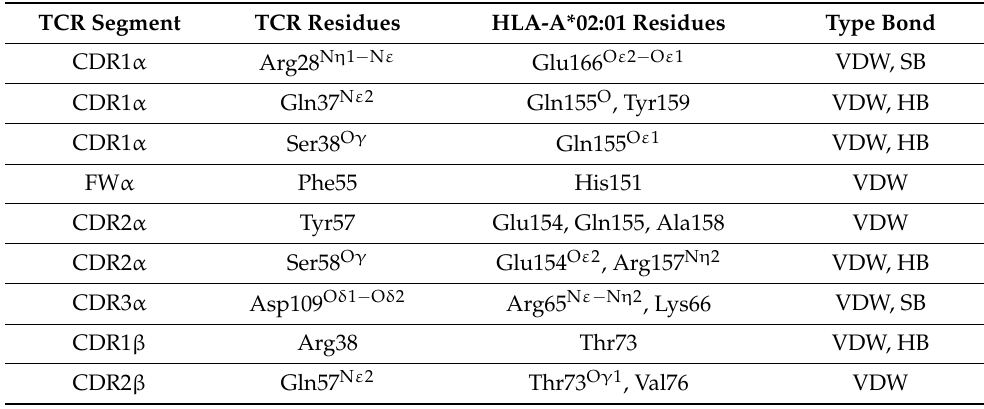
Figure 3. YLQ-SG3 TCR affinity and structure with HLA-A*02:01-YLQ. ( A ) SPR sensorgram and ( B ) steady-state binding curve for YLQ-SG3 TCR towards HLA-A*02:01-YLQ. Analyte HLA-A*02:01- YLQ flowed over immobilised YLQ-SG3 TCR with a concentration range of 0.19 to 50 µ M. ( C ) The footprint of the YLQ-SG3 TCR shows atomic contact with the HLA-A*02:01-YLQ complex. The surface of HLA-A*02:01 is white, the surface of the YLQ peptide is grey. Each atom is coloured by the TCR segment they are contacted by, which for the CDR1/2/3 α is deep teal, chartreuse and purple, for the CDR1/2/3 β is red, orange and yellow and the β -chain framework is light blue. The pink and blue spheres represent the mass centre of the α - and β -chain, respectively. ( D ) The overview of the YLQ-SG3 TCR ( α -chain in pink, β -chain in blue) is represented as cartoon on the top of the YLQ peptide (pink spheres) presented by the HLA-A*02:01 (beige cartoon, with the β 2m in grey cartoon). The TCR CDR loops are coloured as per panel C. Table 5. Contacts between the YLQ-SG3 TCR and HLA-A*02:01-YLQ